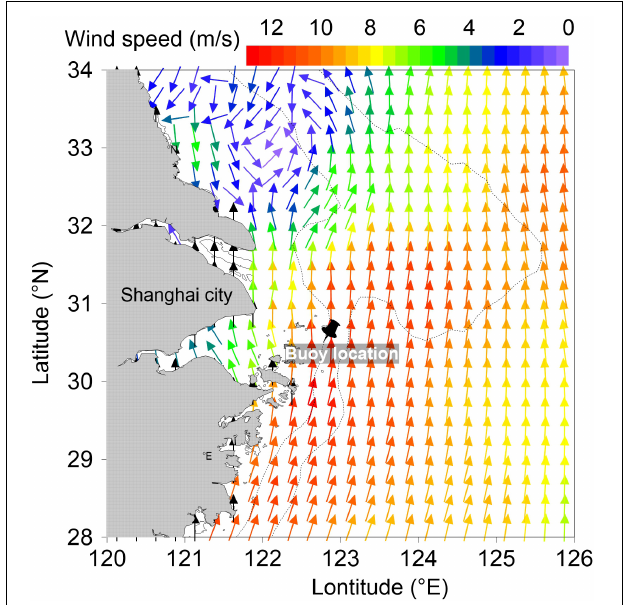
FIGURE 1 | Advanced Scatterometer winds over the East China Sea on July 24. The black pin denotes the buoy location. The colors represent the wind